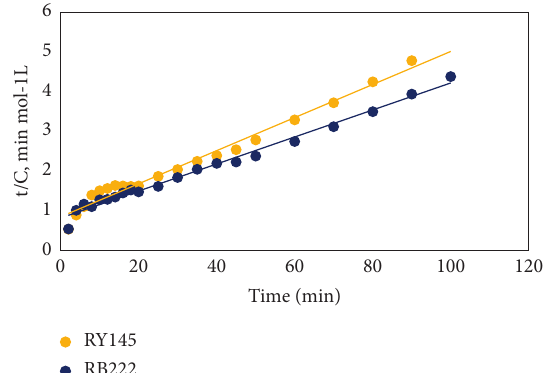
Figure 18: Pseudo - second-order kinetic model for extraction of RY145 and RB222 dyes at concentration 6 × 10 − 5 mol/10 ml by CTAB surfactant concentration 9 × 10 − 2 mol/10